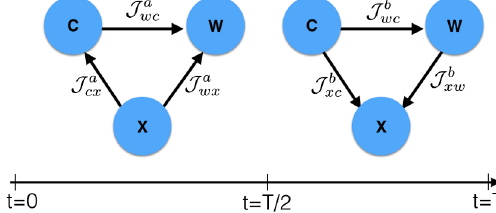
FIG. 6. Patters of currents in periodically driven kinetic proof- reading. In the first half-cycle (left), both currents are out of the state x , and in the second half-cycle (right), they are both into the state x